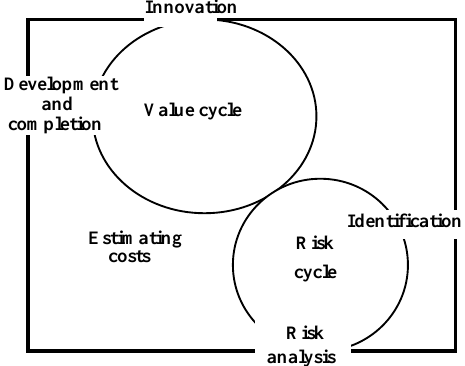
Fig. 3. Risk analysis within the value